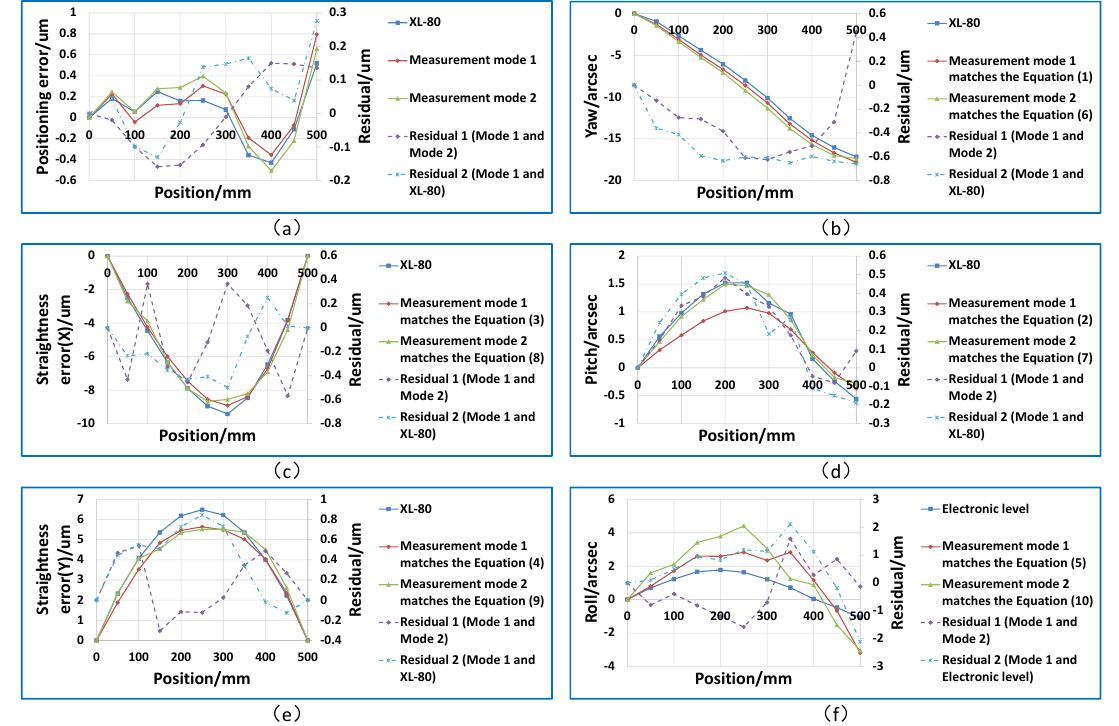
Figure 7. Experimental results of comparison between the two measurement modes and between measurement mode 1 and commercial instruments. ( a ) Positioning error; ( b ) Yaw error; ( c ) Straightness error (X); ( d ) Pitch error; ( e ) Straightness error (Y); ( f ) Roll error.